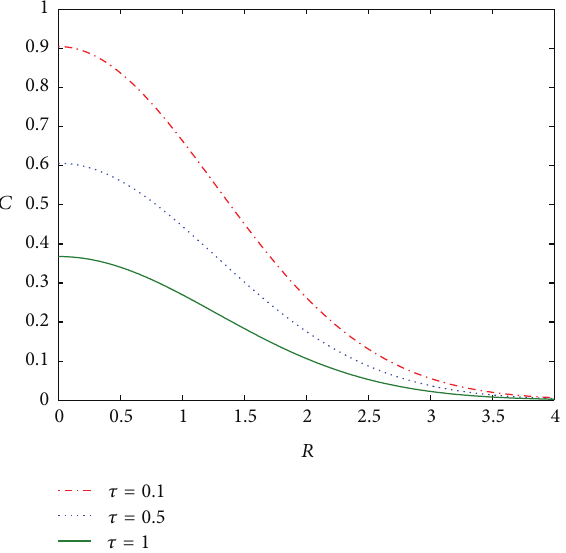
Figure 8: Concentration profile for solution given in (39). Here 𝑅 = 𝑅